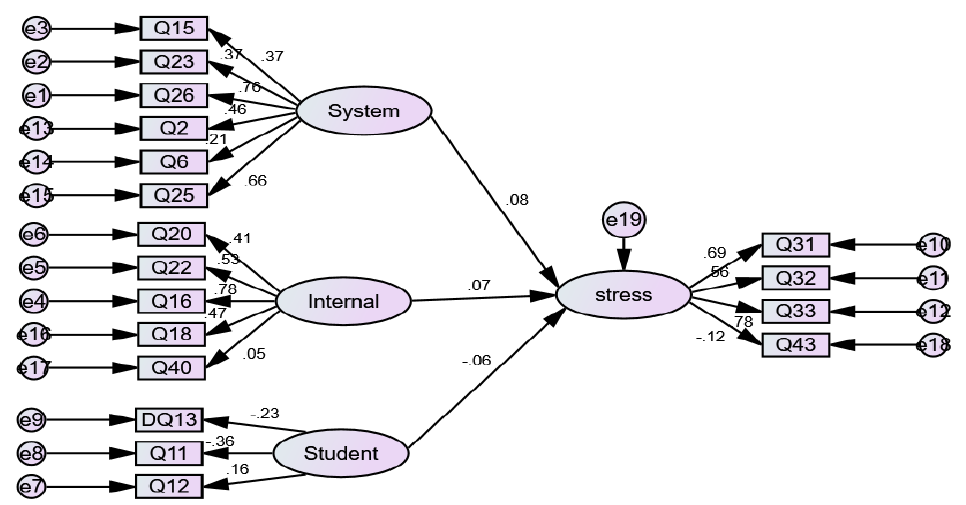
Figure 7. Causal model of stress.